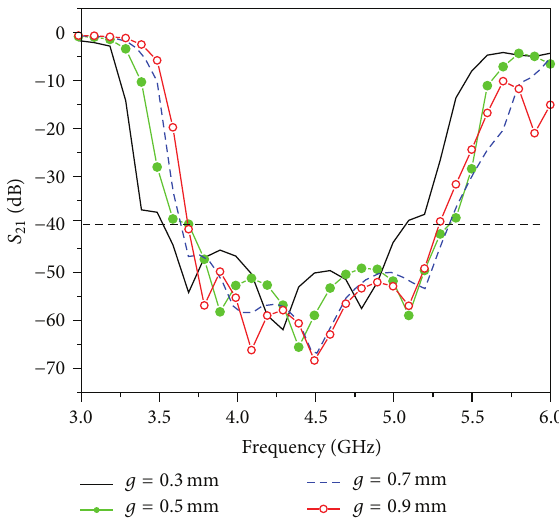
Figure 5: Simulated 𝑆 21 as a function of 𝑟 . Figure 6: Simulated 𝑆